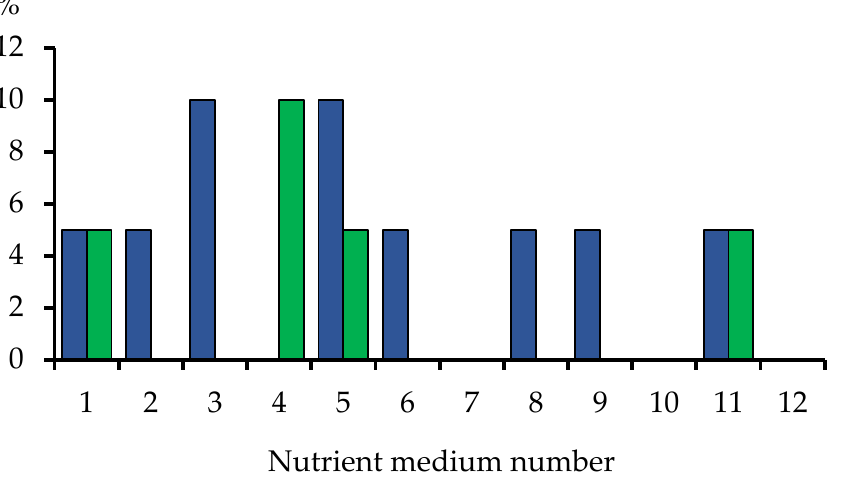
Figure 2. Frequency of callus formation on different nutrient media. Note: blue bars indicate Petrozavodsk SO, green bars—Petrozavodsk park.